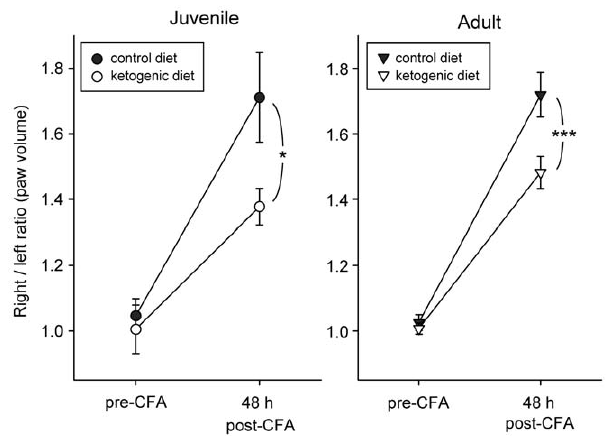
Figure 2. Hindpaw inflammatory swelling is reduced in juveniles and adults fed the ketogenic diet. Control diet – filled symbols, ketogenic diet – empty symbols for juveniles ( left ) and adults ( right ). Hindpaw volumes are shown as right/left ratios, measured just prior to and 48 h after injection of CFA into the right hindpaw. As expected, baseline ratios are similar to 1.0 in all groups. CFA-induced swelling was similar in juvenile and adult rats (71% and 72%, respectively), and was attenuatedsignificantlybythe ketogenic diet in bothage groups. Analysis of juveniles indicated a significant effect of CFA (F=68.7, p , 0.001), and a significant diet x CFA interaction (F=5.4, p , 0.05). Analysis of adults indicated significant effects of CFA (F=183.6, p , 0.001) and a significant diet x CFA interaction (F=7.5, p , 0.05). Numbers of subjects: 7 for juvenile control diet, 6 for juvenile ketogenic diet, 12 for adult control diet, 11 for adult ketogenic diet. * p , 0.05, *** p , 0.001 Newman-Keuls comparisons